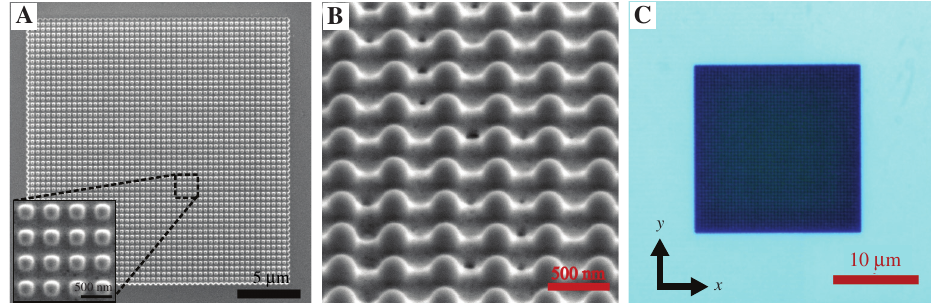
Figure 4: Scanning electron microscopy (SEM) and reflection images of the fabricated metamaterial. (A) SEM images of the metamaterial (scale bar: 5 μ m). Inset: SEM image of the enlarged area. (B) Tilted SEM image at the tilt angle of 52 ° . (C) Reflection image of a MAPbBr film. Decreased reflection is observed in the middle part where the metamaterial is 3